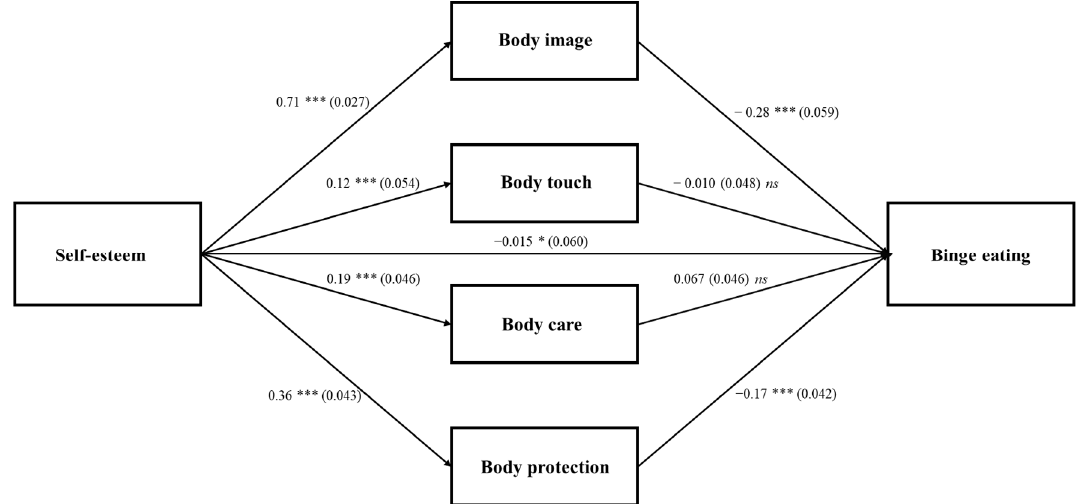
Figure 2. Females model: Standardized path analysis coefficients and standard errors * p < 0.05, *** p < 0.001, ns —not significant.